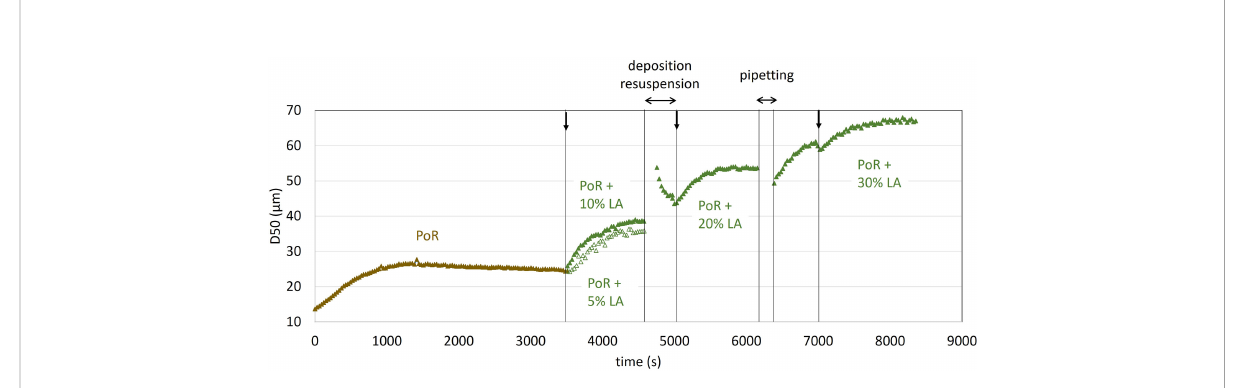
FIGURE 6 Mean particle size (D50) evolution as function of time. The vertical arrows indicate injection of Living Algae (LA). See text for